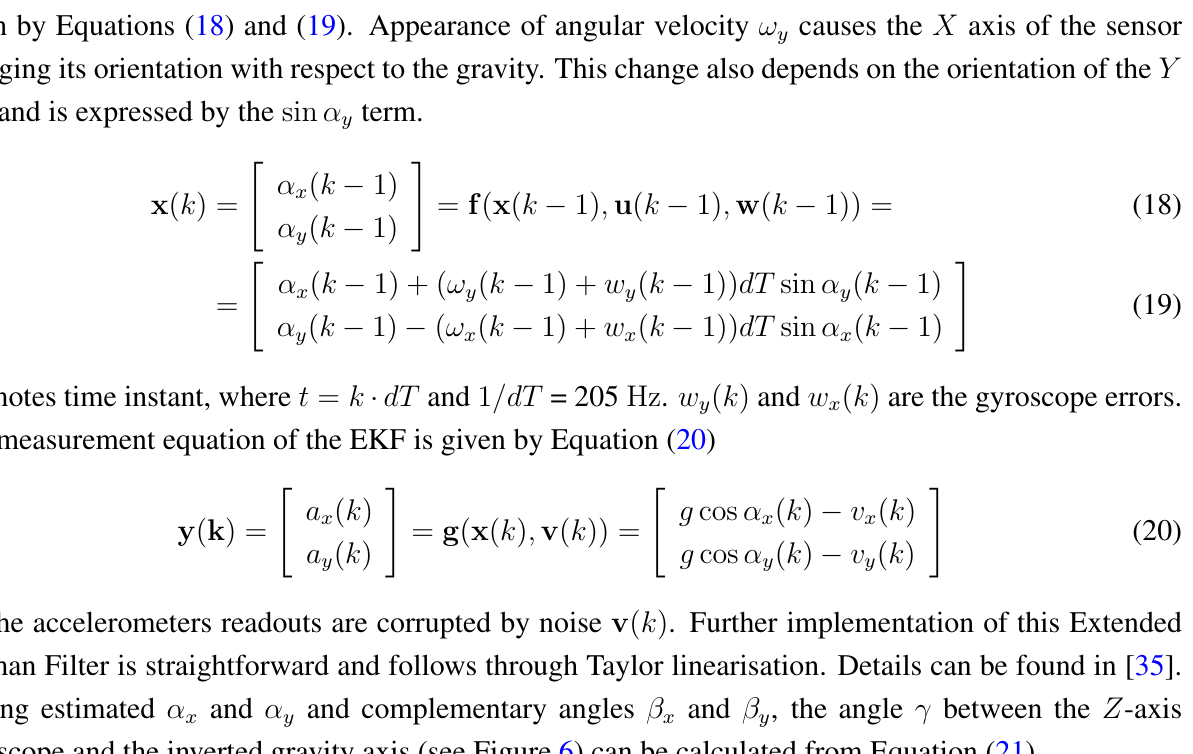
and β and the angle γ which describes x y